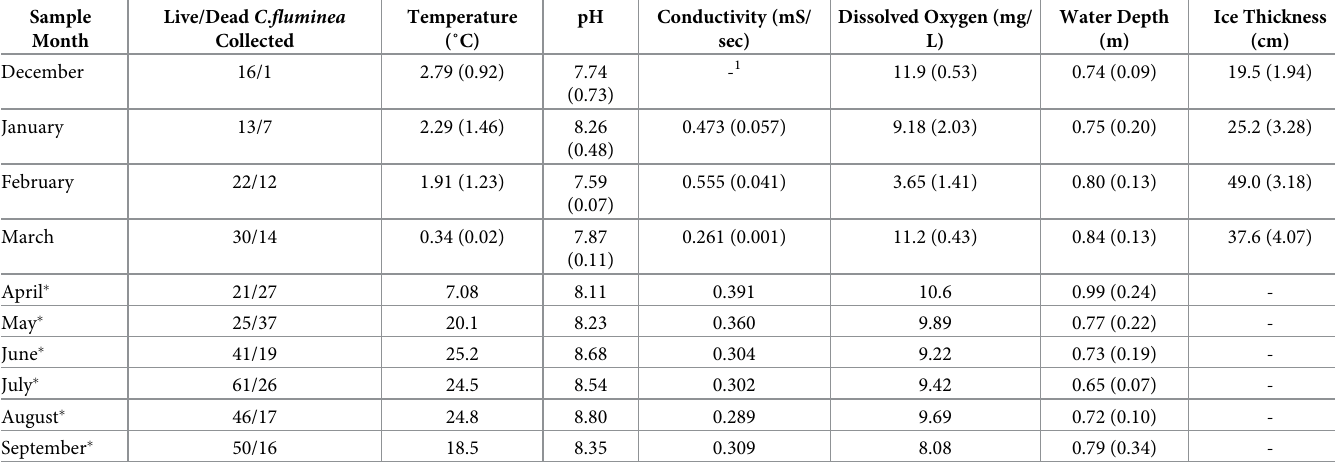
Table 1. Monthly mean ( SD ) environmental data.